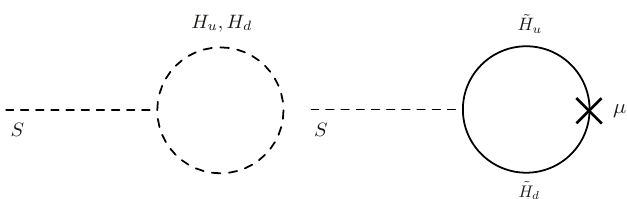
Figure 11 . Tadpole diagrams originating from the non-standard soft terms in the presence of the gauge singlet chiral